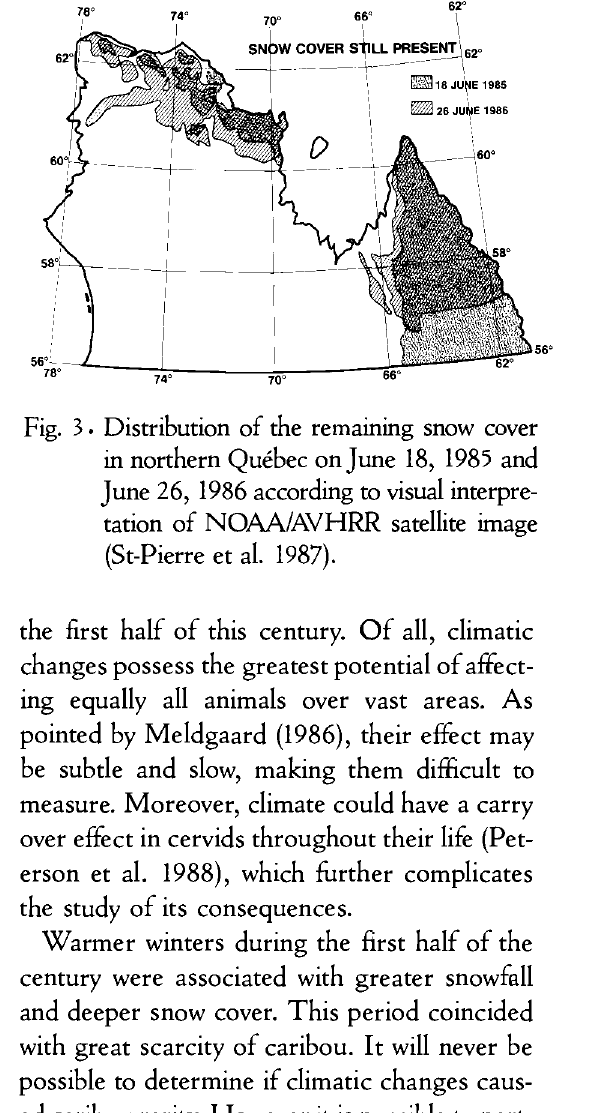
Fig. 3. Distribution of the remaining snow cover in northern Québec on June 18, 1985 and June 26, 1986 according to visual interpre tation of N O A A / A V H RR satellite image (St-Pierre et al.